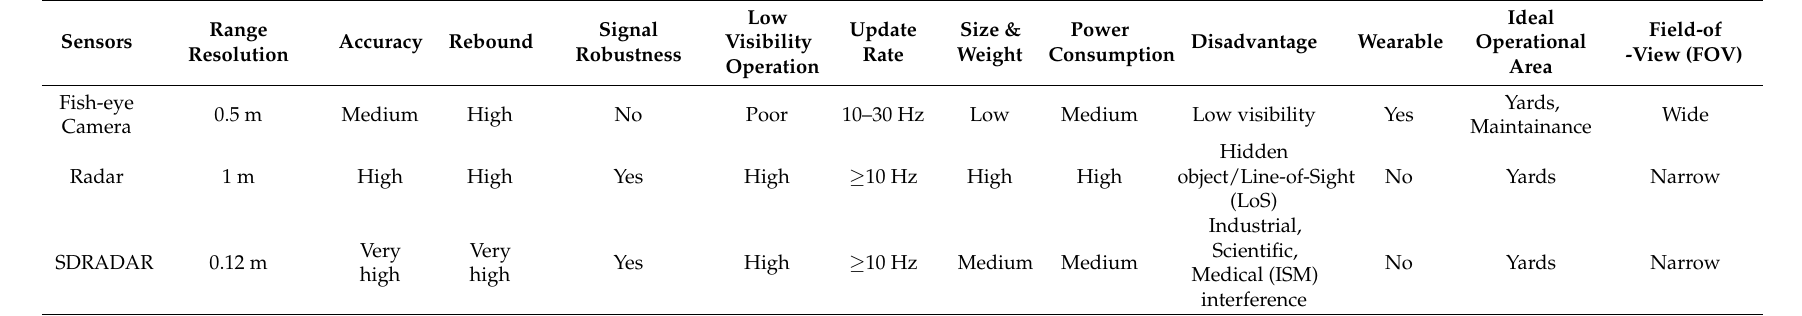
Table 2. Comparison between RADAR vs. fish-eye